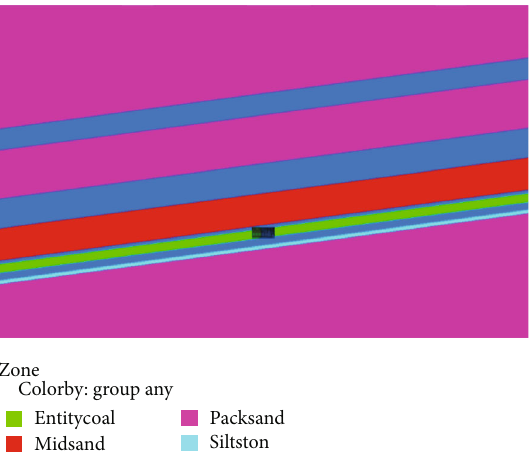
Figure 10: The numerical model.